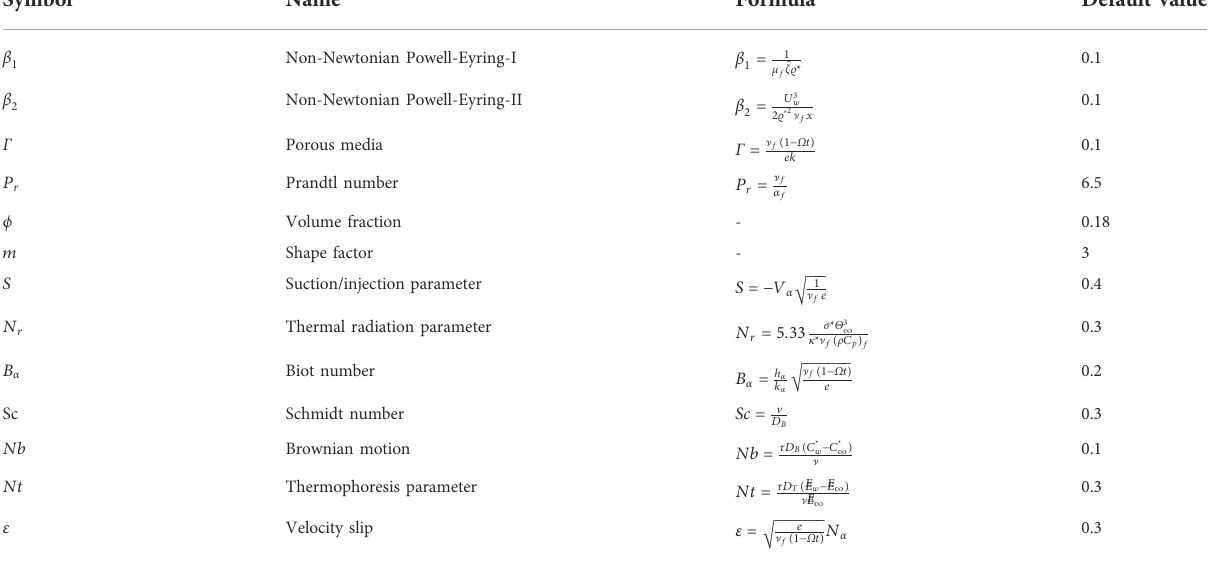
TABLE 3 Explanation of the entrenched control constraints.